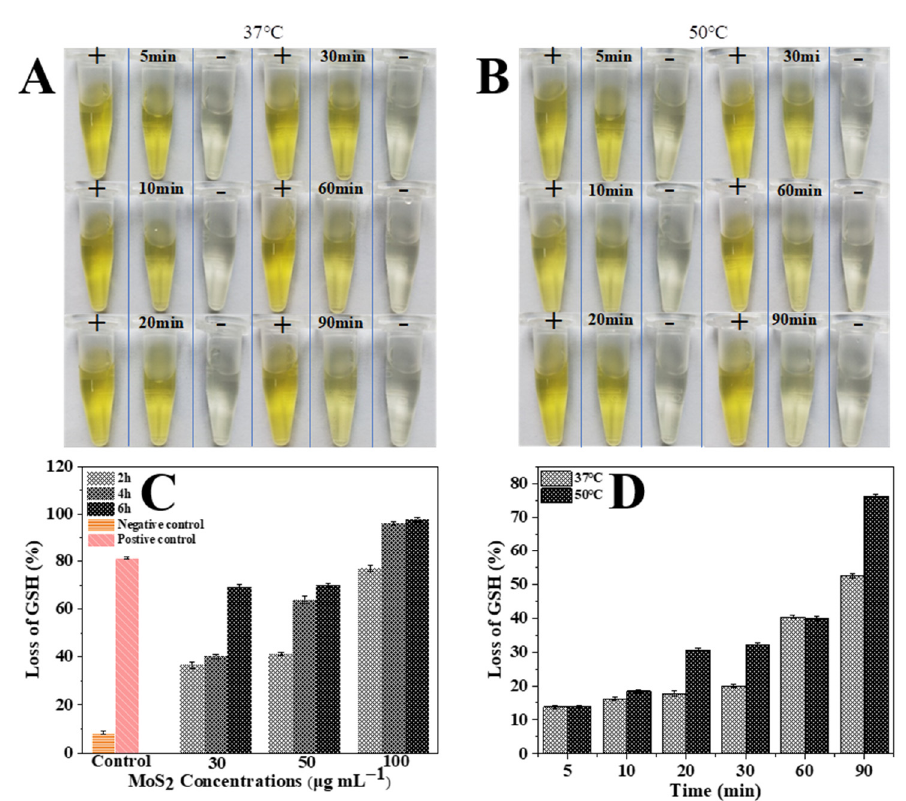
Figure 7. Effect of PEG-MoS 2 NFs on glutathione oxidation at different reaction times (5 min, 10 min, 20 min, 30 min, 60 min, 90 min) at 37 ◦ C ( A ) and 50 ◦ C ( B ), respectively. ( C ) GSH loss rates of PEG- MoS 2 NFs dispersions with different concentrations at 37 ◦ C for different reaction times. ( D ) GSH loss rates of PEG-MoS 2 NFs dispersions with a concentration of 100 µ g/mL at 37 ◦ C and 50 ◦ C for different reaction times, respectively.